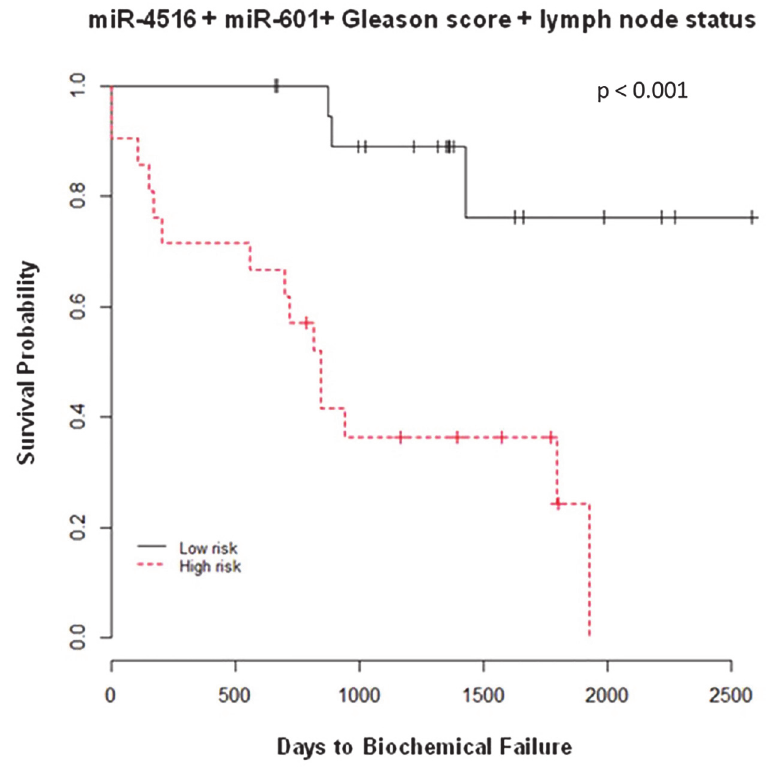
Fig 4. Kaplan-Meier plot estimates of miRNA-based predictive salvage RT model. A K-M plot was generated using the miR-4516 + miR-601 + Gleason score + lymph node status model for biochemical recurrence post salvage radiation therapy. Patients were divided into high and low risk groups dichotomized by the median risk